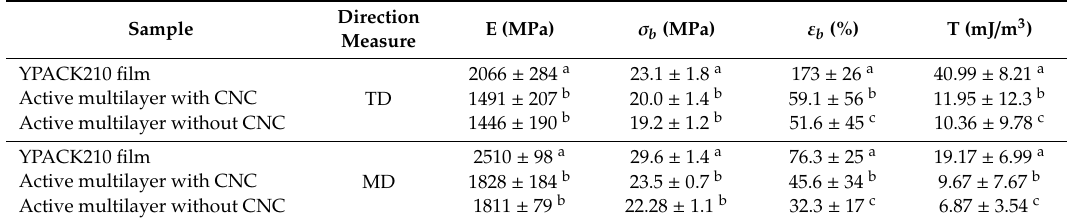
Table 3. Mechanical properties in terms of elastic modulus (E), tensile strength at break ( σ b ), elongation at break ( ε b ), and toughness (T) of the YAPCK210 film and active multilayer films with and